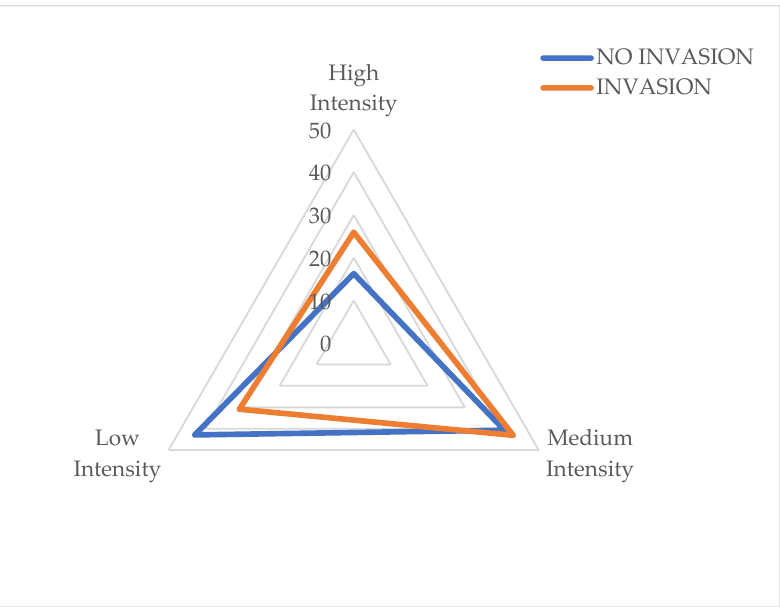
Figure 4. Percentage of activities of low, moderate (medium), and high intensity at the investigated Greek Natura 2000 sites with no invasion (No I; 0%) contrasted to those with invasion by Solanum elaeagnifolium (sites with low, moderate, high, and very high invasion pooled together).